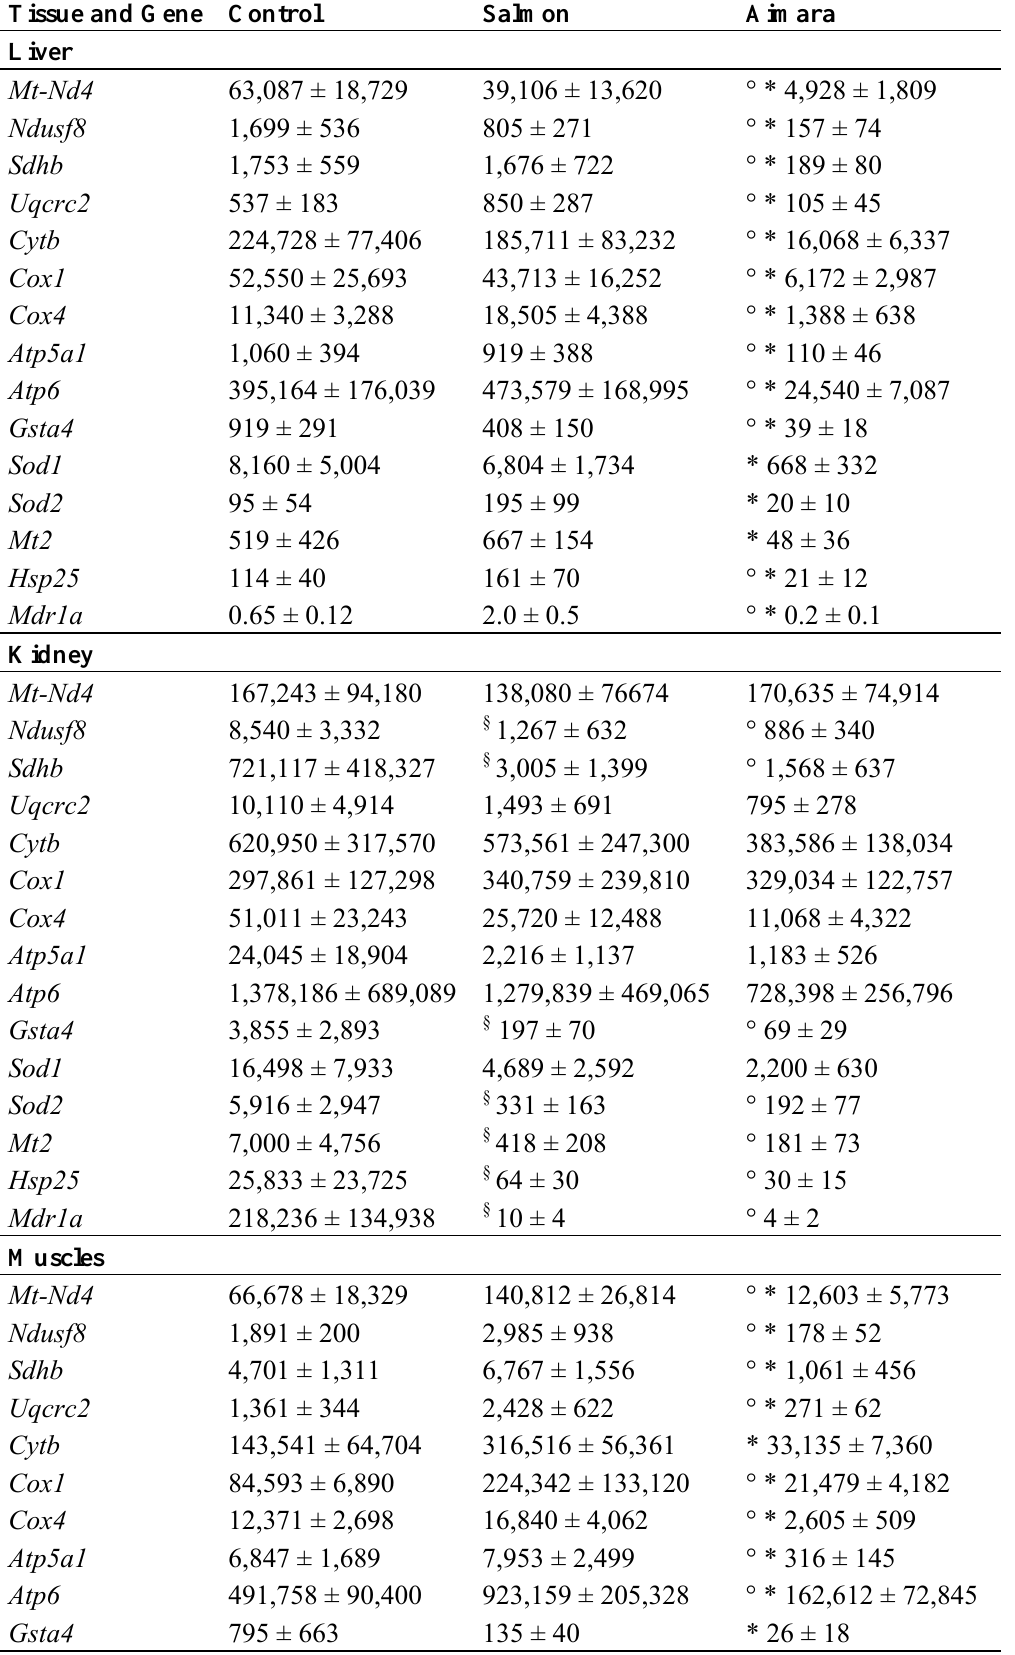
Table 9. Gene expression in tissues from wild-type mice fed fish-containing diets for 14 months a . Tissue and